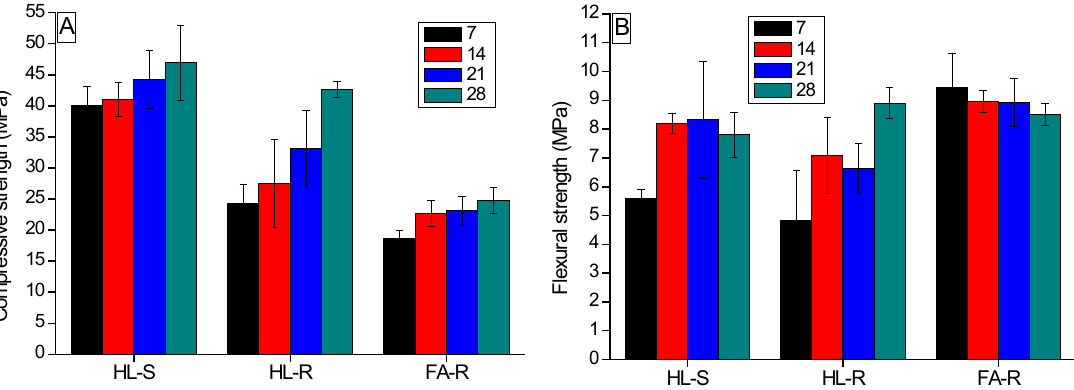
Figure 7. Compressive ( A ) and flexural ( B ) strength of dense MK-S, MK-R and FA-R specimens as a function of the curing time.